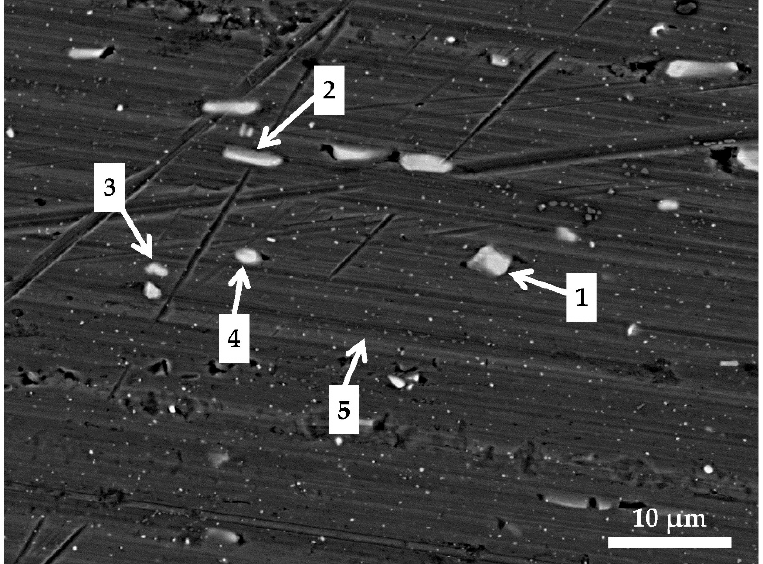
Figure 3. SEM backscattered electron micrograph of AA3003 chemically pre-treated using ST/HNO 3 . The enumerated spots are the locations at which EDS analysis was performed (Table 2). Table 2. The concentrations of elements obtained by EDS analysis at different locations on the chemically pre-treated sample with Surtec 132/089 and 50% HNO 3 (Figure 3). Location at.% O at.% Al at.% Mn at.% Fe at.% Si at.% Cu at.% F